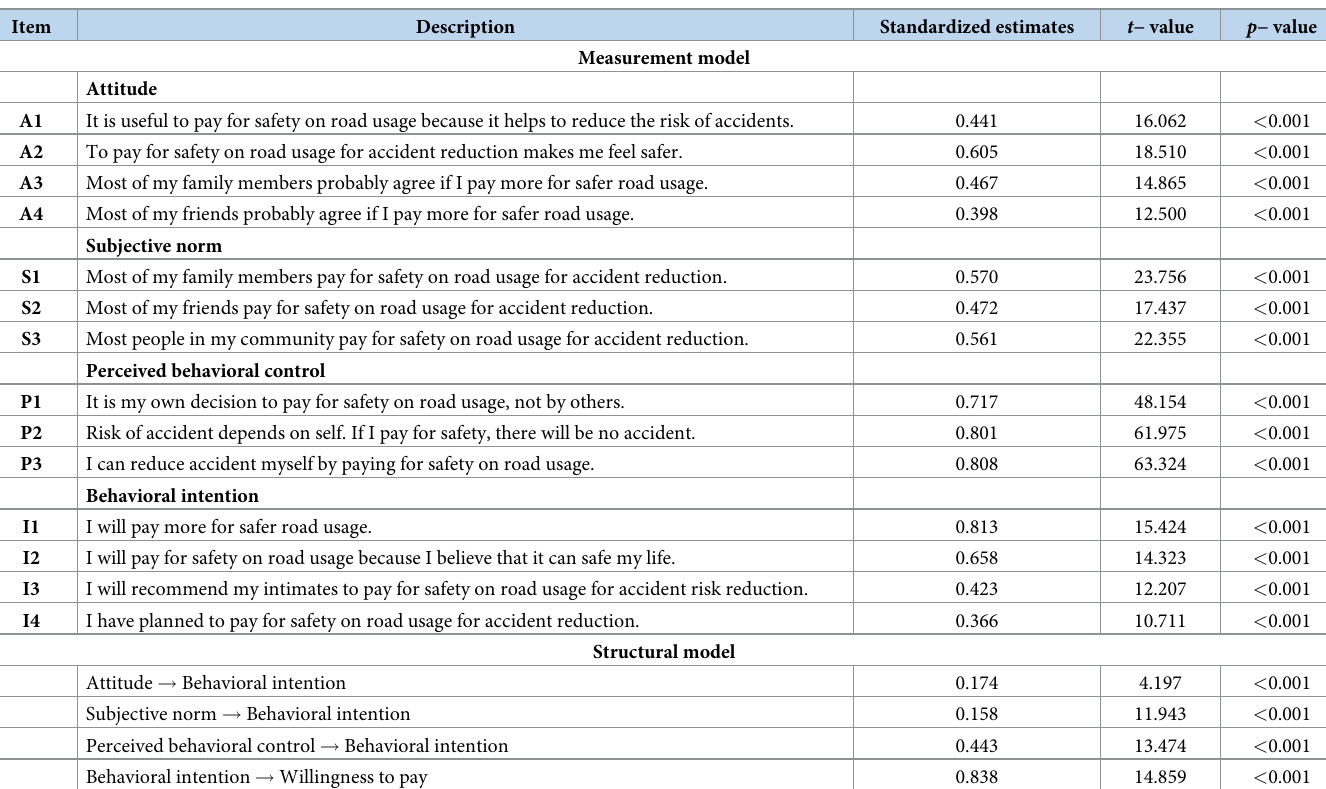
Table 5. Standardized model